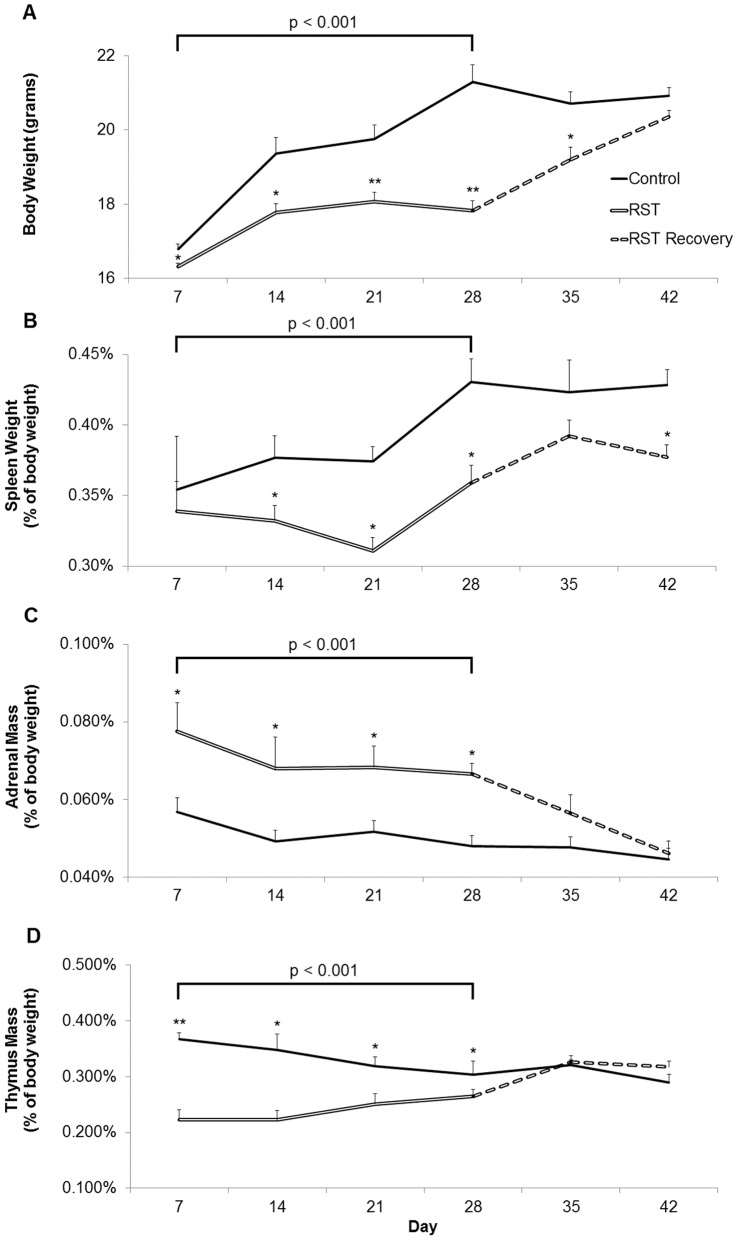
Prolonged RST evoked sustained elevations in stress response.Bodyweight (A), splenic mass (B), adrenal mass (C), and thymic mass (D) were examined during (solid lines, Day 7–28) and following stress cessation (broken lines, Day 29–42). For each data point n = 10 individuals. Data shown is mean +SEM. *p<0.05; **p<.0001. Data were collected without repeated sampling of individuals.